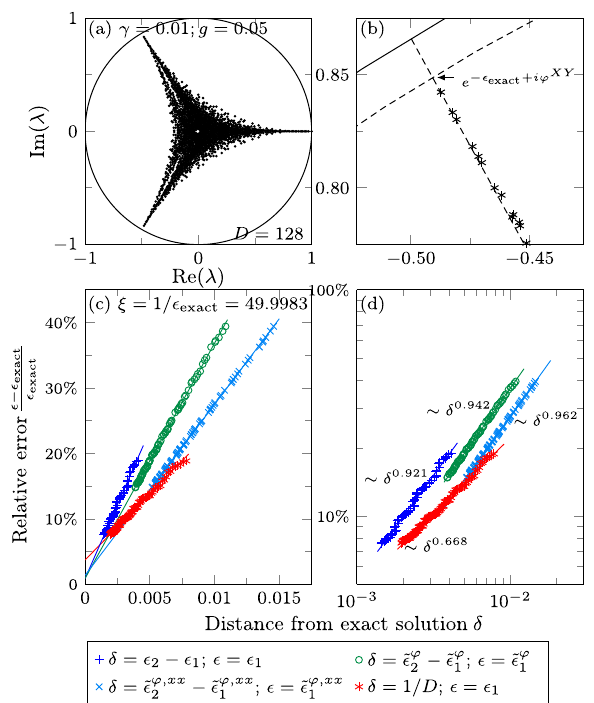
FIG. 3. XY model in the ferromagnetic incommensurate phase, γ ¼ 0 . 01 and g ¼ 0 . 5 . Panel (a) shows full TM spectrum for D ¼ 128 . The branch with complex angle ≃ φ XY is enlarged in (b), where the dashed lines show phase and modulus correspond- ing to the exact correlation length, respectively. We show the results of linear extrapolation in (c), focusing on D ¼ 128 – 512 . The same data are plotted in (d) in a log-log scale showing the dominant power-law dependence of relative error on the refine- ment parameter δ